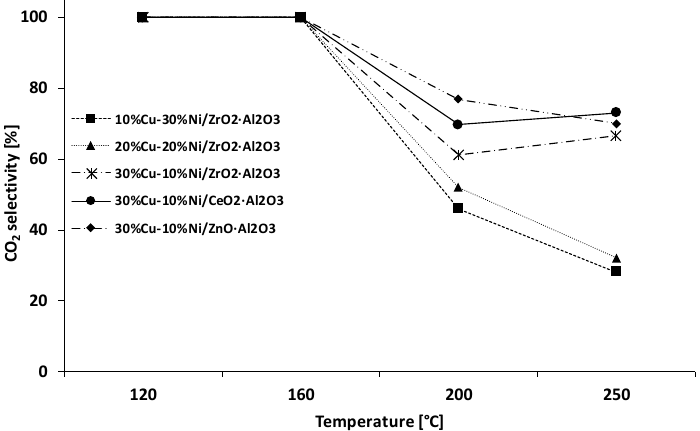
Figure 3. The influence of the reaction temperature of bimetallic catalysts on the selectivity towards CO 2 formation in the OSRM process.